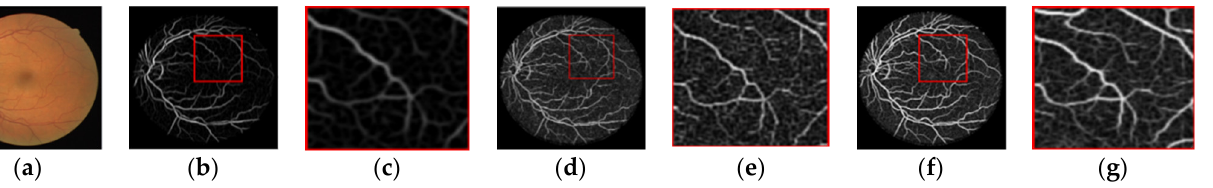
Figure 4. Comparison of multi-scale and single-scale vascular extraction. ( a ) original image; ( b ) σ 1 = 1.9; ( c ) Detail amplification of σ 1 = 1.9; ( d ) σ 3 = 0.13; ( e ) Detail amplification of σ 3 = 0.13; ( f ) multi-scale fusion vascular extraction image; ( g ) Detail amplification of multi-scale.